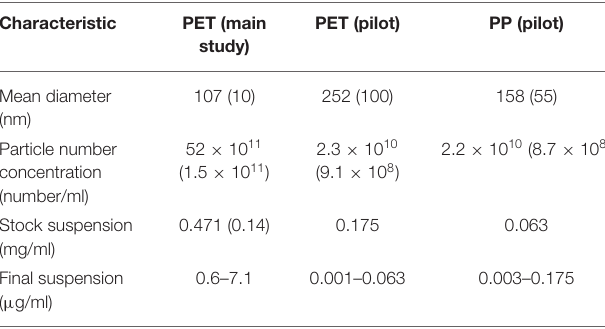
TABLE 2 | Hydrodynamic particle size and concentration data from the Nanosight experiment a .